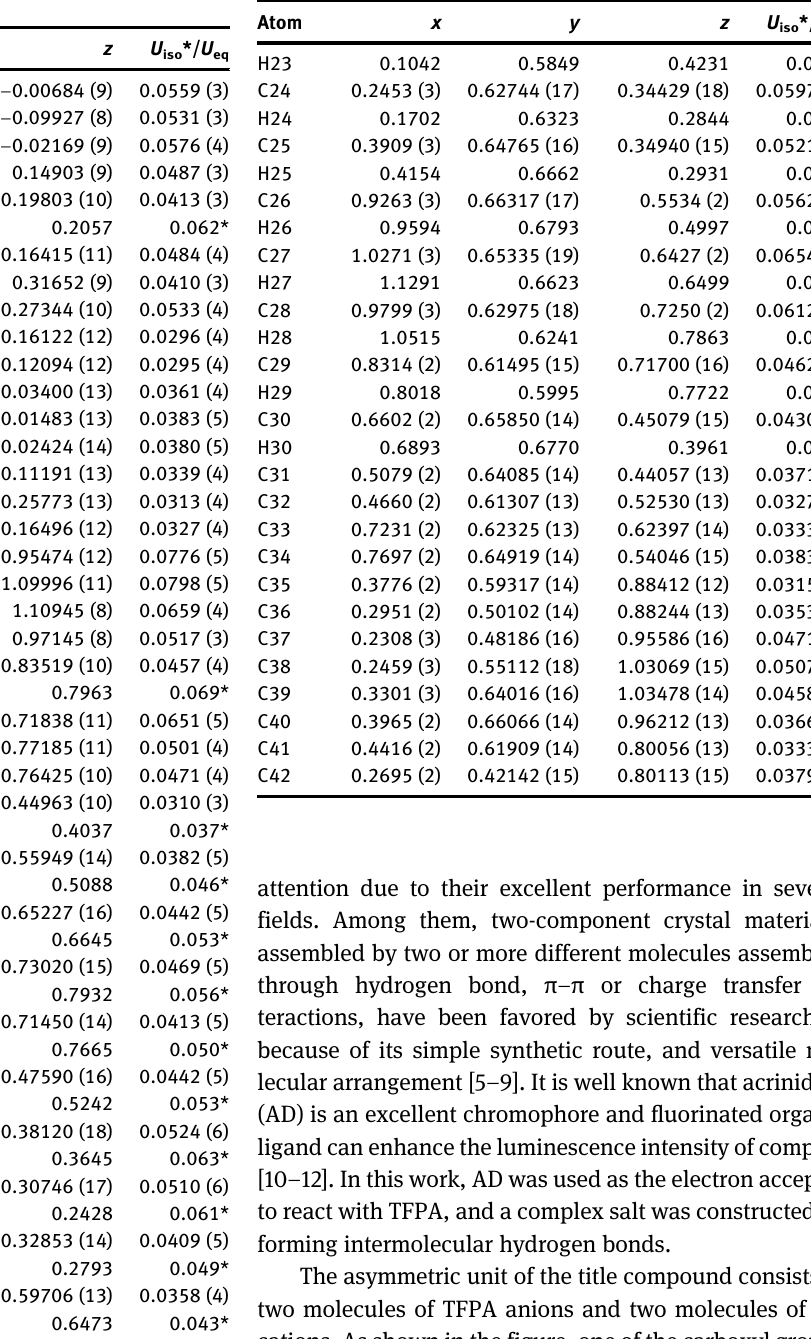
Table  : Fractional atomic coordinates and isotropic or equivalent isotropic displacement parameters (Å 